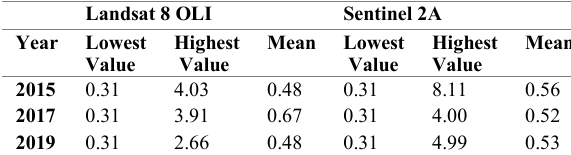
that permits for both the dependent and independent variables to possess comparable error and implies that swapping the dependent and independent variables (i.e., the Sentinel-2A and Landsat-8 band data) won't alter the bivariate relationship. The corresponding results of individual sensor (Sentinel 2Aand Landsat OLI) type was compared for the results generated from both pixel and index based classification using the coefficients of a linear regression and the Pearson correlation coefficient in other to identify whether they have a good linear correlation, or the regression lines depart slightly from the identity